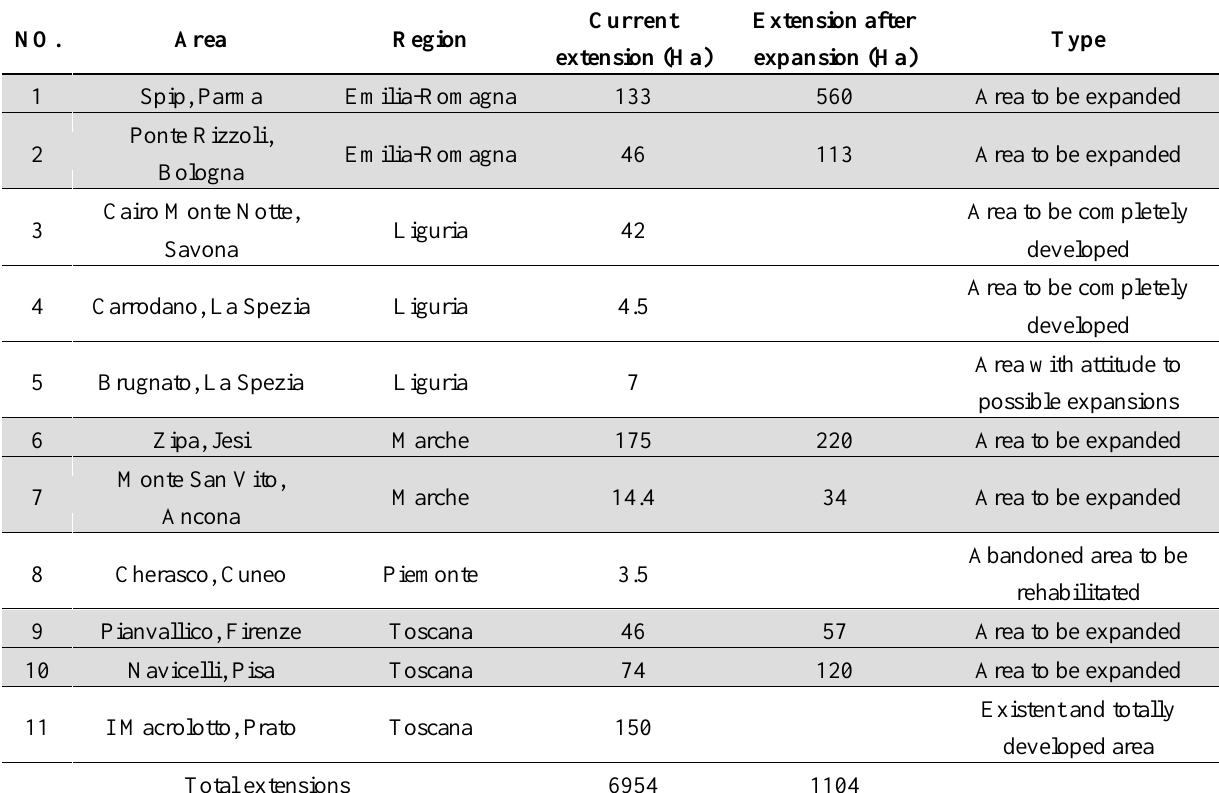
Table 3. Dimensional data of the 11 analyzed areas (data from the Ervet study, 2010